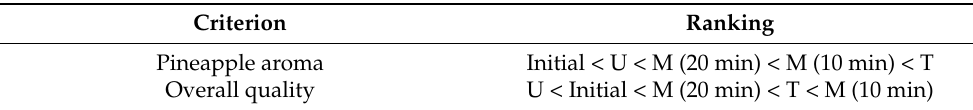
Table 4. Results obtained from the ordering of the samples based on pineapple aroma and overall quality (aromatic intensity, absence/presence of defects). U: ultrasound; T: traditional; M: microwave 10–20 min extraction. Initial: unmacerated vinegar